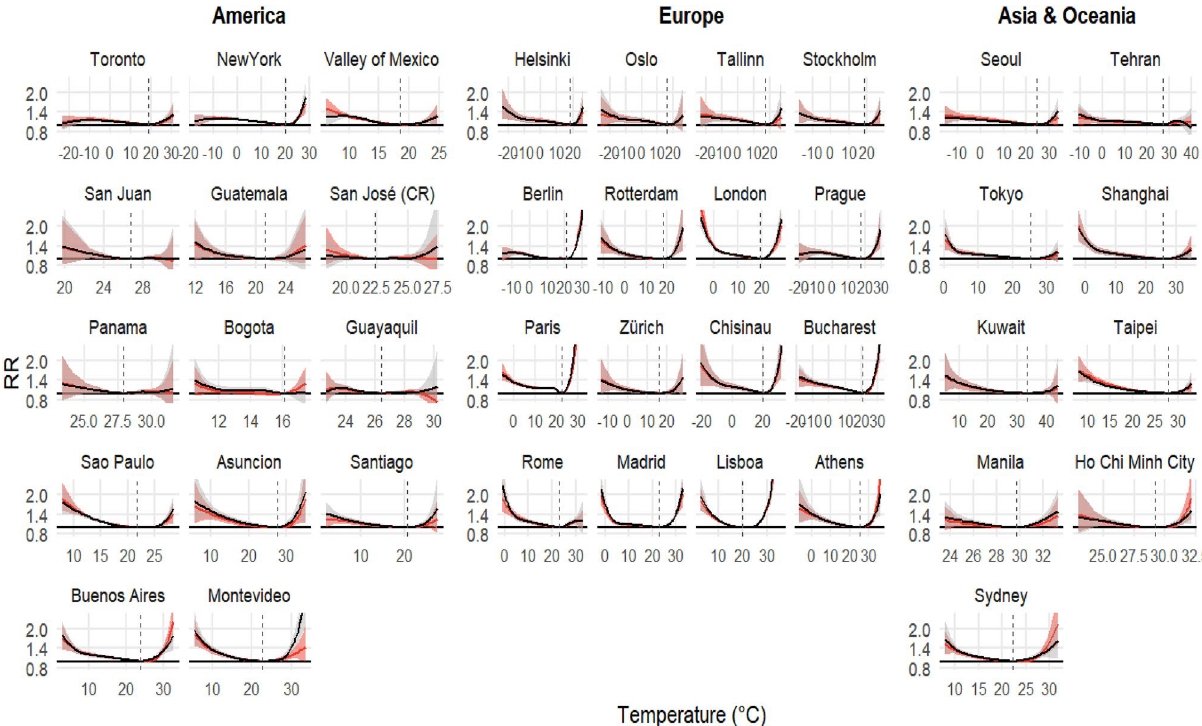
Figure 3. Overall cumulative exposure–response associations in selective cities representative of the 39 countries (station observations—black and ERA5-Land—red, with 95% confidence intervals (CI)—shaded, see “Methods”). Exposure–response associations as best linear unbiased prediction (BLUP, see “Methods”) using the distribution drawn from station temperature. Dashed vertical grey lines are the minimum mortality temperatures (MMTs). RR relative